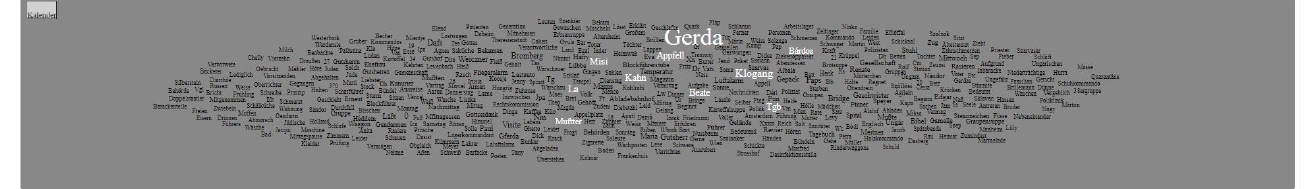
Figure 3. Tag cloud for each month of the year, showing the tf-idf frequency of tokens assigned to the size. The top 10 words are highlighted in white.